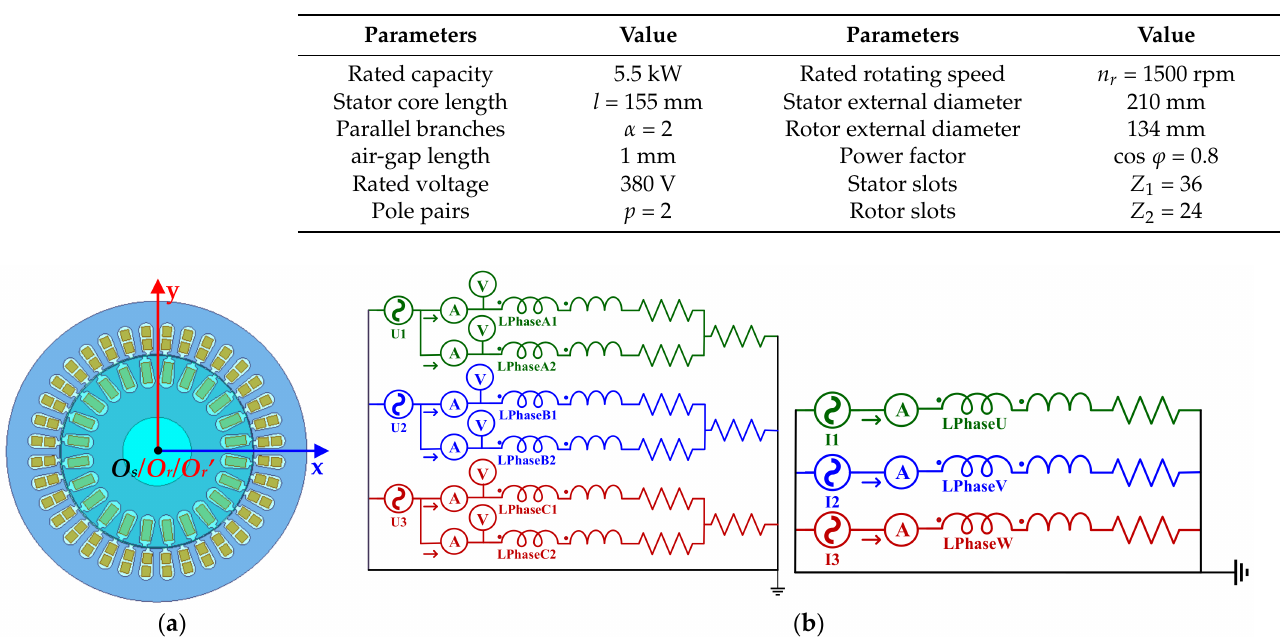
Table 4. Parameters of DFIG prototype generator.